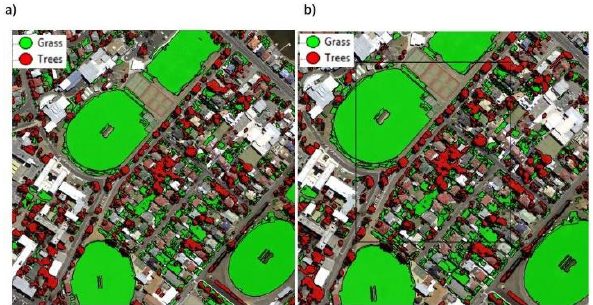
Figure 4. Before and after selecting the test region a) subset of the study area with ground truth of trees and grass b) selecting the test region within the subset.